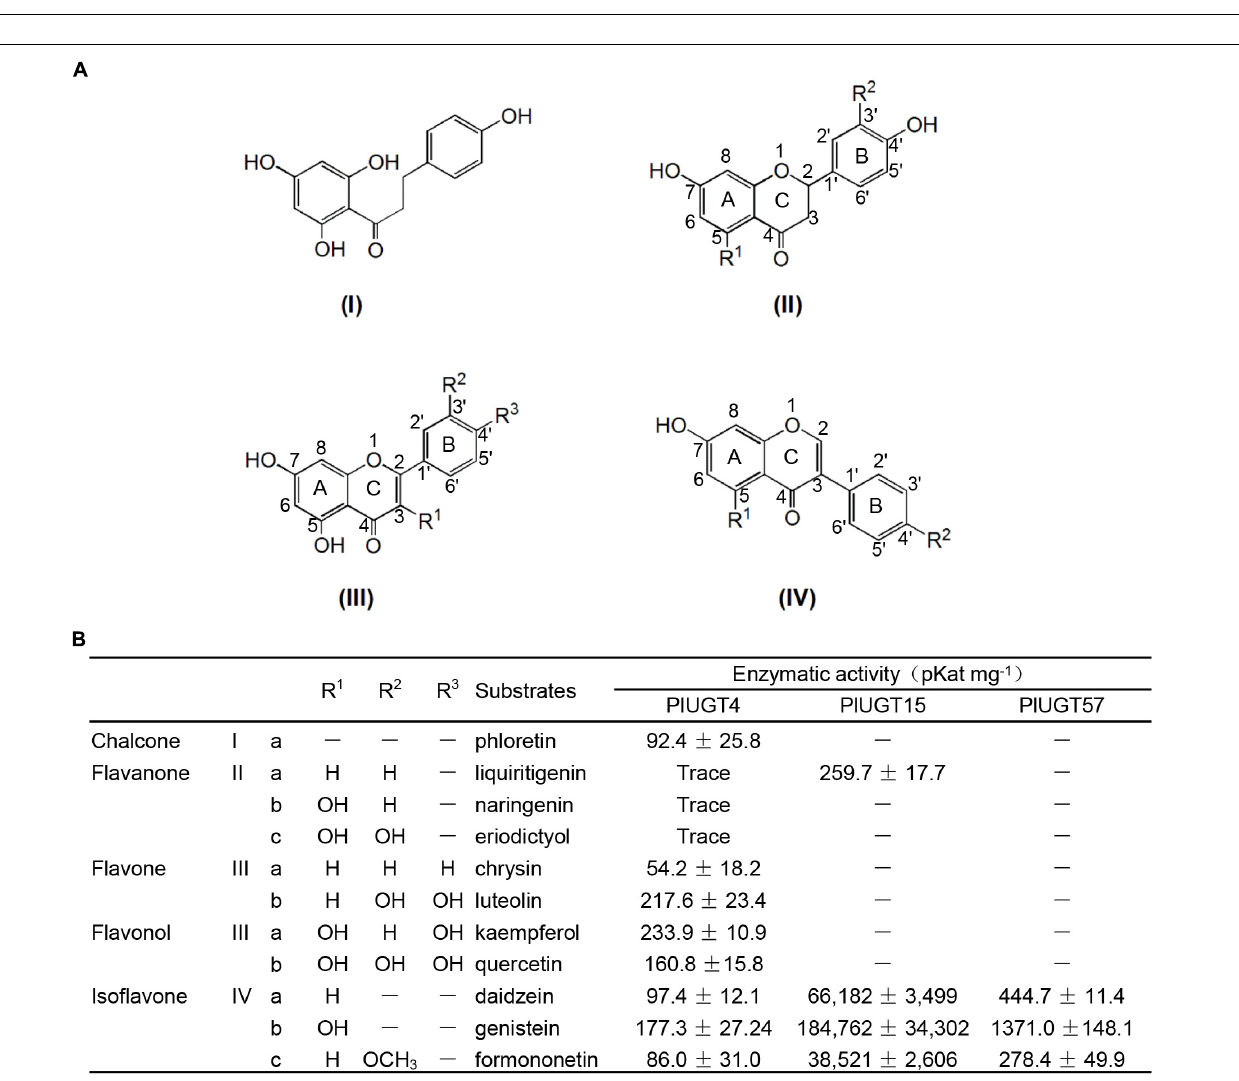
FIGURE 3 | Enzyme activities of three recombinant PlUGTs with different (iso)flavonoid substrates. (A) Chemical structures of (iso)flavonol substrates; (B) enzyme activities of the recombinant PlUGT4, PlUGT15, and PlUGT57 with 11 (iso)flavonol aglycones as acceptor substrates and UDP-glucose as the donor substrate. Values represent the means ± SD from three replicate